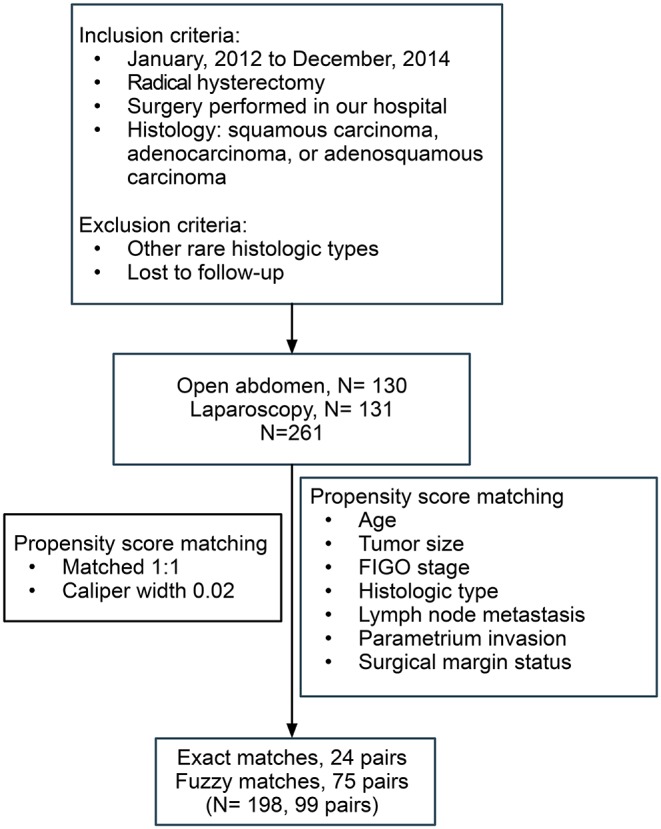
The flow of patients included in this study.